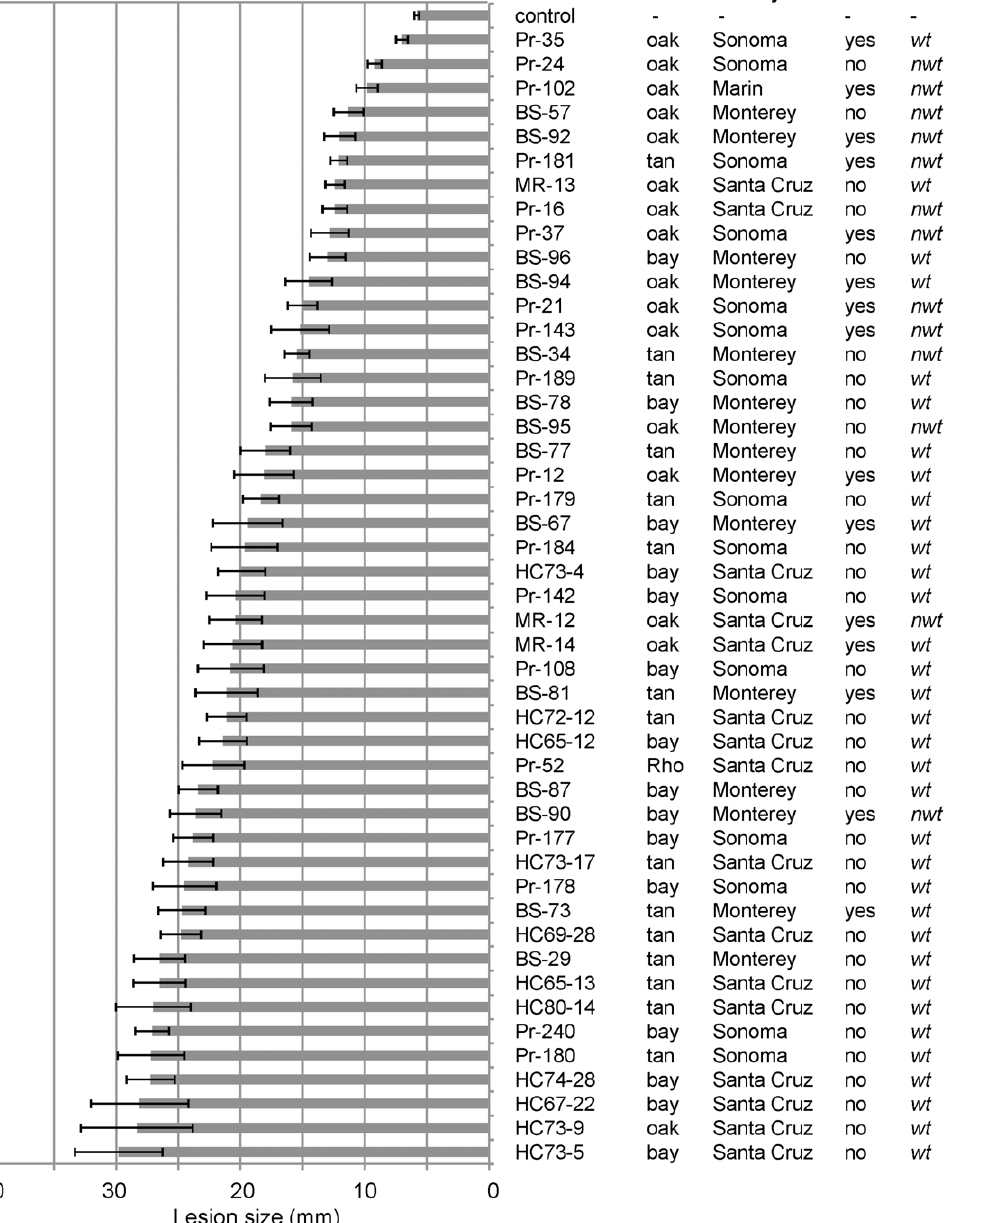
Figure 1. Variation in virulence of Phytophthoraramorum isolates on oak stems. Lesion lengths in stems (n=10) of coast live oak were measured 16 days after inoculation. An average lesion length + / 2 1 standard deviation for each isolate are shown. Originating host species are: oak, coast live oak; bay, California bay laurel; tan, tanoak; and Rho, Rhododendron catawbiense . Originating counties of isolates are also shown. Colony morphologies are: wt , wild type; and nwt , non-wild